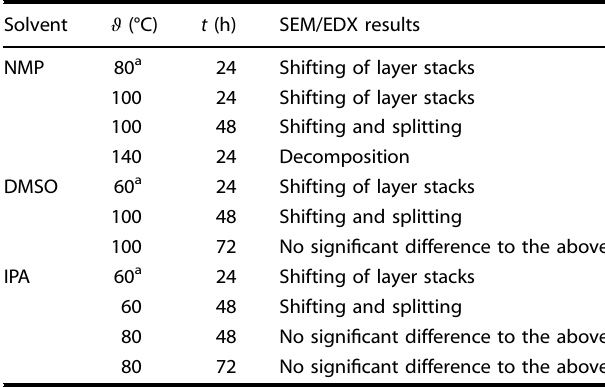
a SEM image is depicted in Fig. 2 as an example of the morphology of the Bi 2 TeI crystals after the